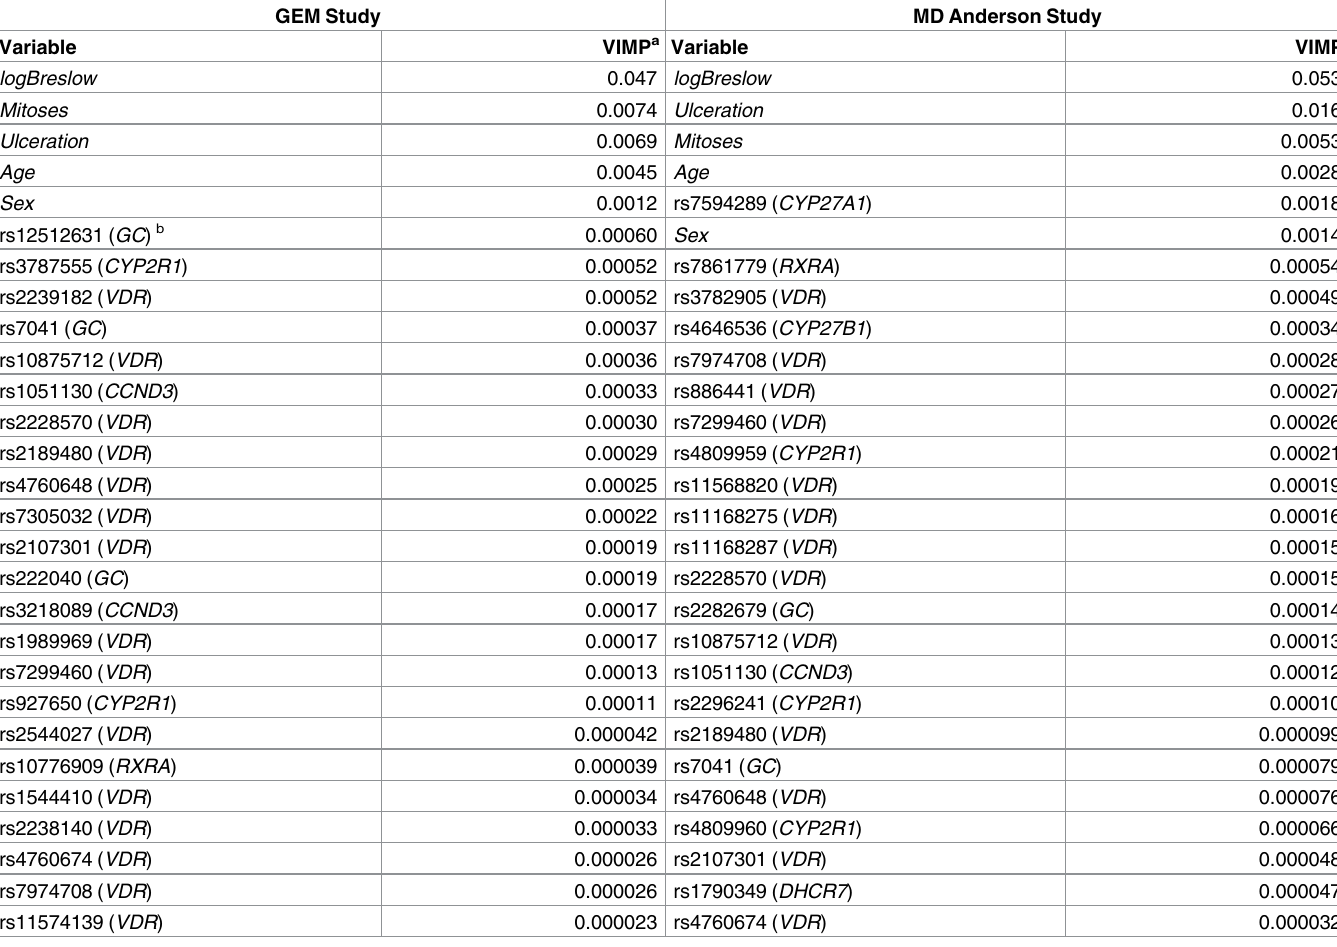
Table 2. The major clinical and demographical prognostic variables and genetic variants selectedby Random Survival Forest (RSF) ordered based on the variable importance (VIMP) prediction